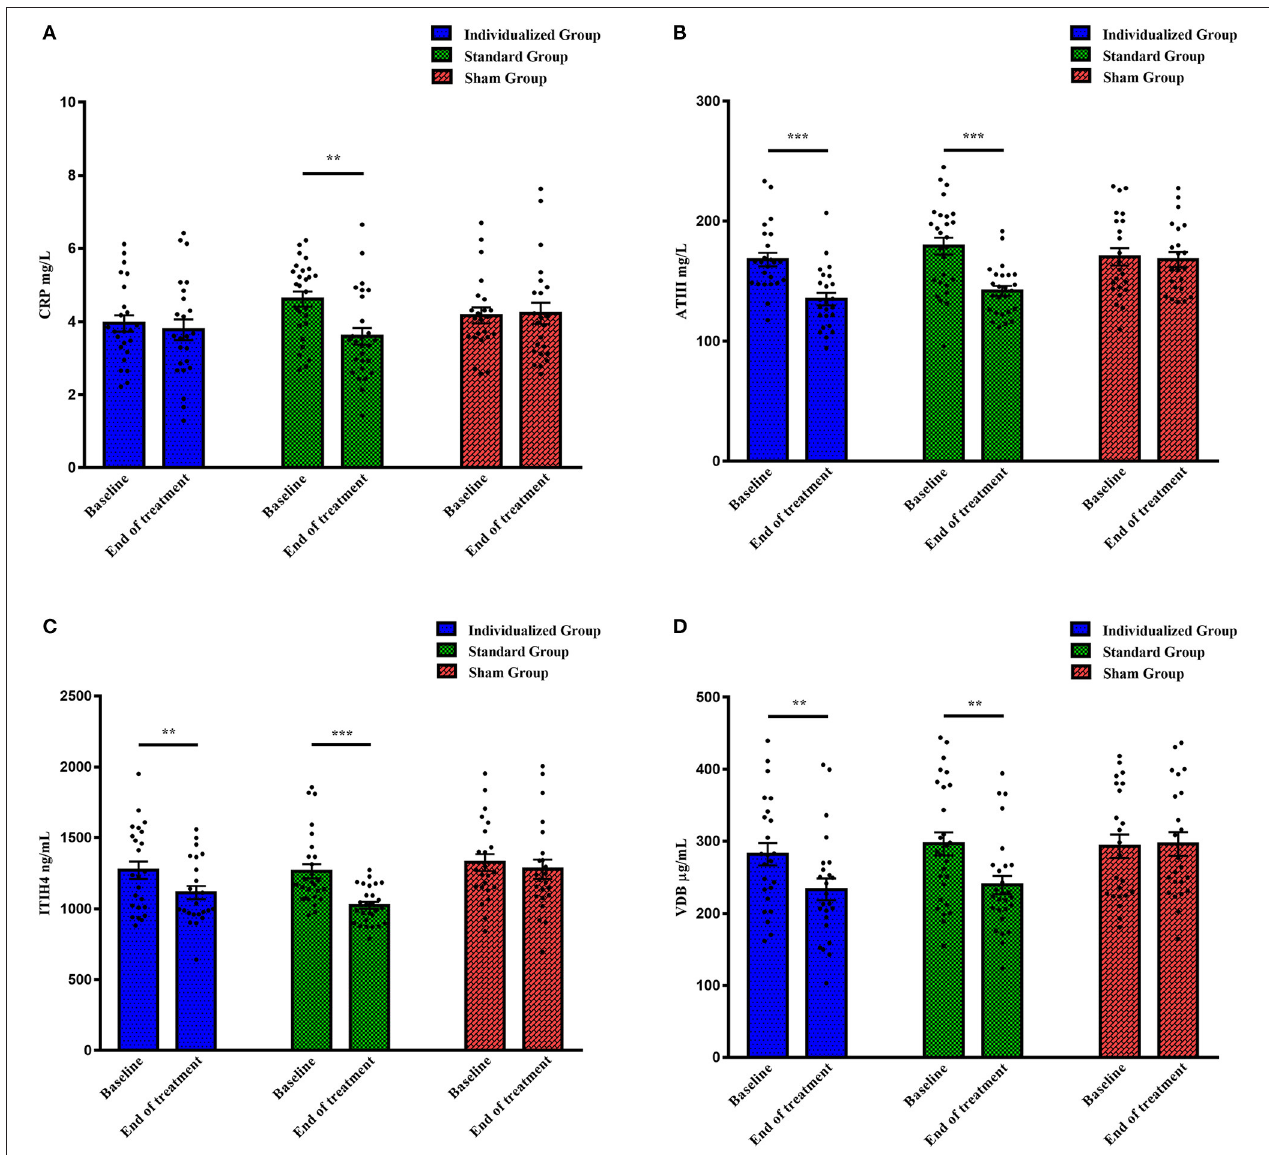
FIGURE 1 | The levels of four proteins in different treatment groups at baseline and the end of treatment. (A) CRP levels (mg/L); (B) ATIII levels (mg/L); (C) ITIH4 levels (ng/mL); (D) VDB levels ( µ g/mL). CRP, C-reactive protein; ATIII, antithrombin III; ITIH4, inter-alpha-trypsin inhibitor heavy chain H4; VDB, vitamin D binding protein. ** p < 0.01, *** p <